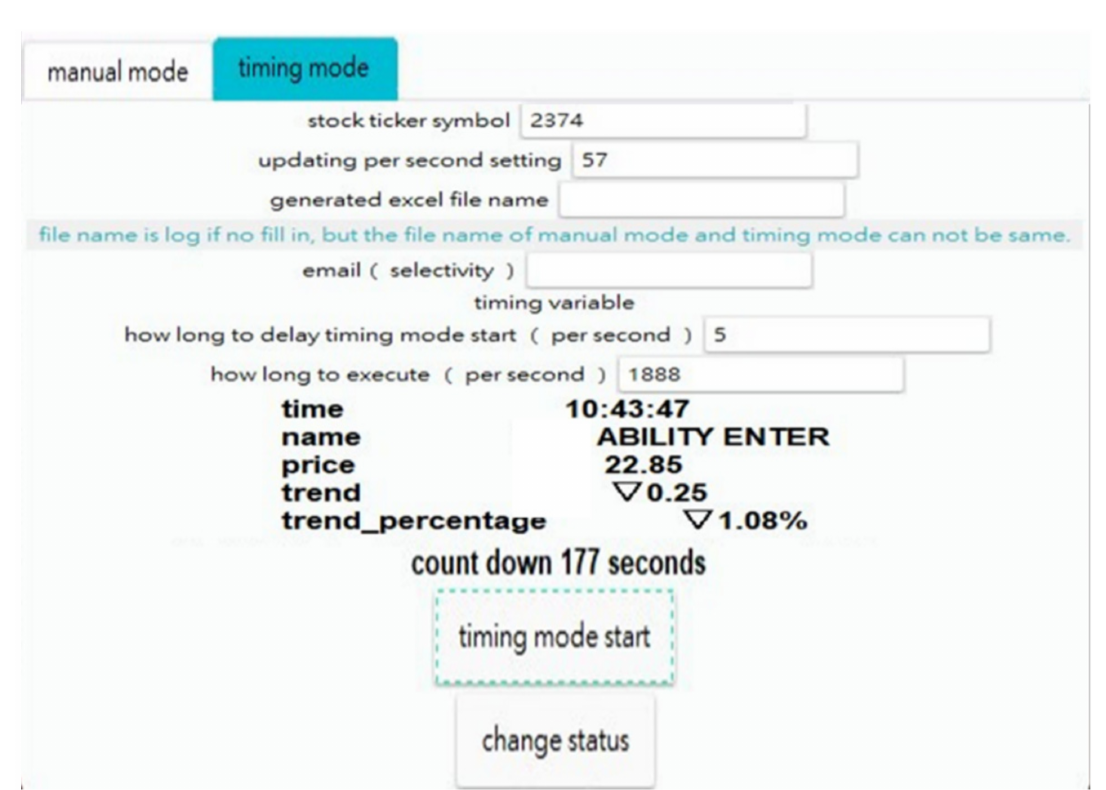
Figure 14. Timing mode count down 177